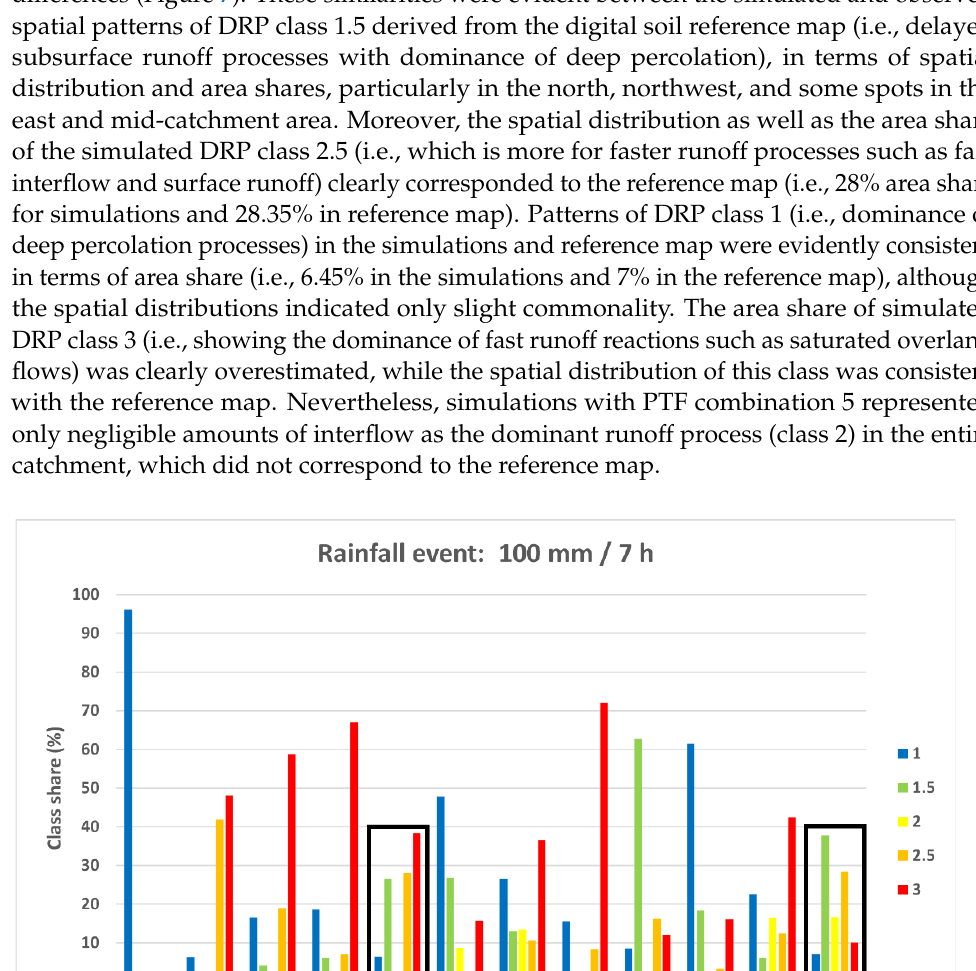
Table 6. Spatial similarities (SPAEF values) between the simulated patterns of DPR (i.e., for all PTF combinations and synthetic rainfall intensities) and the reclassified reference runoff process map. Positive values are in green.